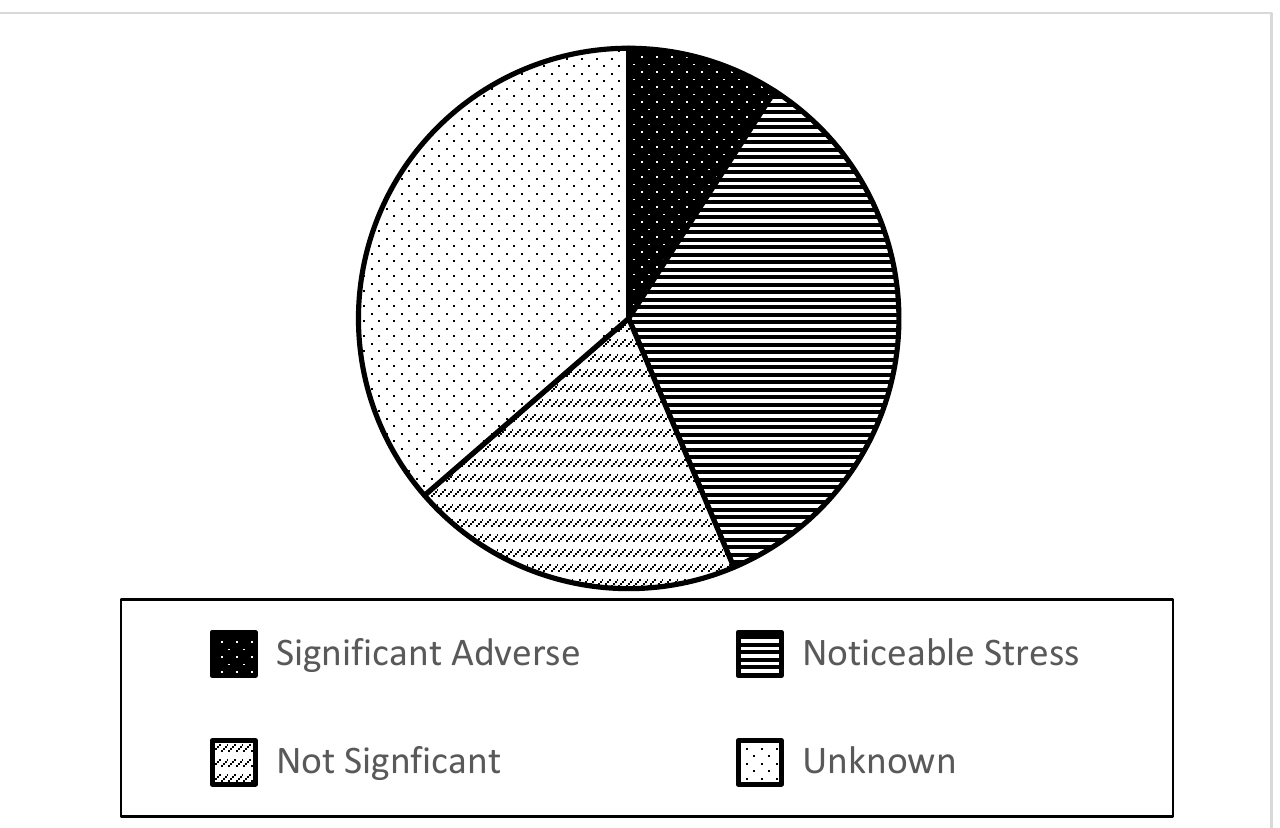
Figure 3. Nonindigenous aquatic plants by impact category—limited to impact attributed to competition with native plant species (n = 55). (Re-analysis of the impact assessments which appear in